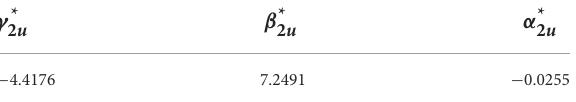
TABLE 6 Parameters estimates of the time-varying model for the upper-tail-dependence coefficients λ * U 2 m .